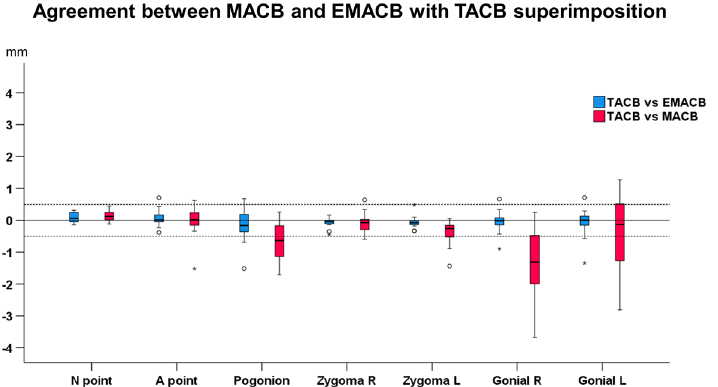
Figure 5. Box plots showing the agreement between EMACB (Extended Middle Anterior Cranial Base) and MACB (Middle Anterior Cranial Base) with the TACB (Total Anterior Cranial Base) superimposition on the detected T0–T1 changes, for all measurement areas. Zero value, depicted by the continuous horizontal line, indicates perfect agreement, whereas any deviation from zero is considered disagreement. The dashed lines indicate 0.5 mm and − 0.5 mm. The upper limit of the black line represents the maximum value, the lower limit the minimum value, the box the interquartile range, and the horizontal black line the median value. Outliers are shown as black circles or stars in more extreme cases.